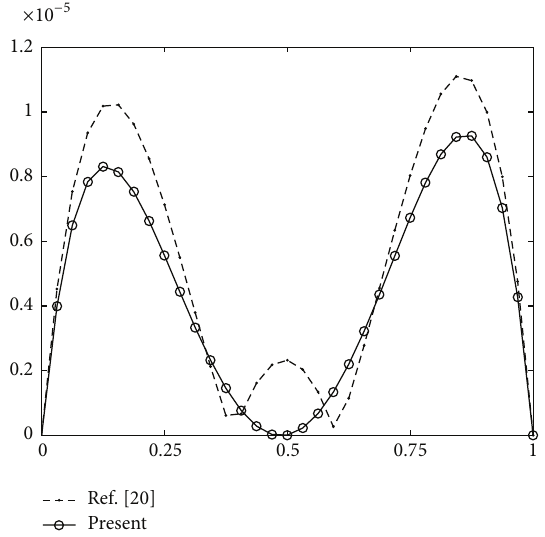
Figure 15: Absolute error distribution at ℎ = 1/32 , 𝜏 = 0.1 , 𝛽 = 1 , 𝛼 = 2 , 𝑝 = 4 , and 𝑡 = 10 .